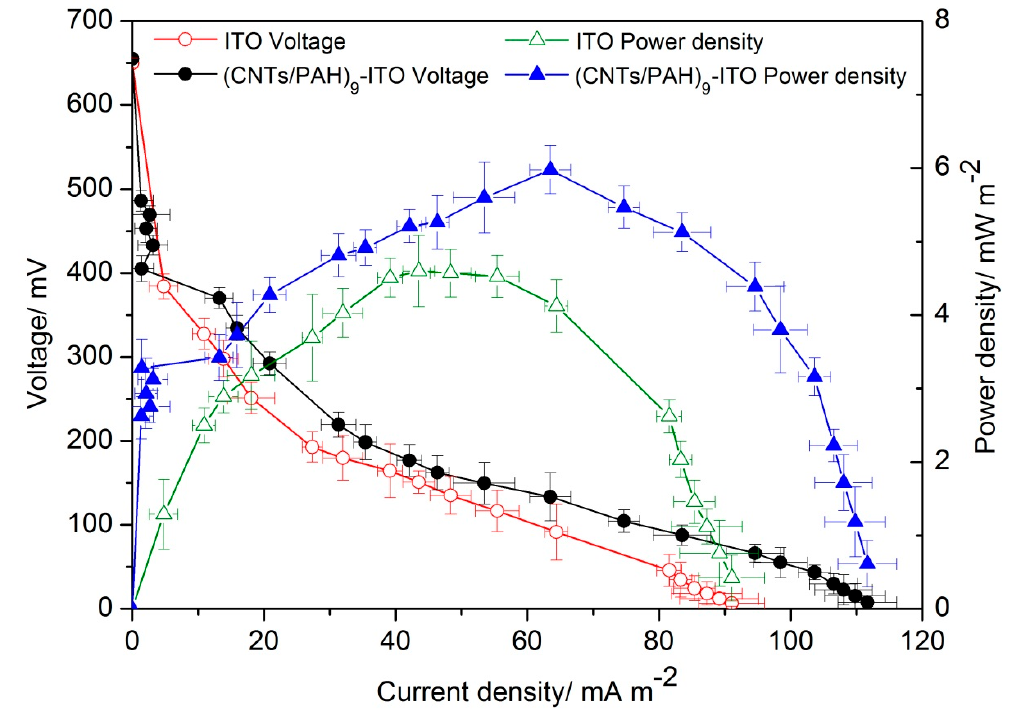
Figure 7. Polarization and power density curves of the MFCs with the (CNTs/PAH) 9 -deposited ITO anode and the bare ITO anode. Table 2. Composition of the maximum power densities of anodes in the MFCs.